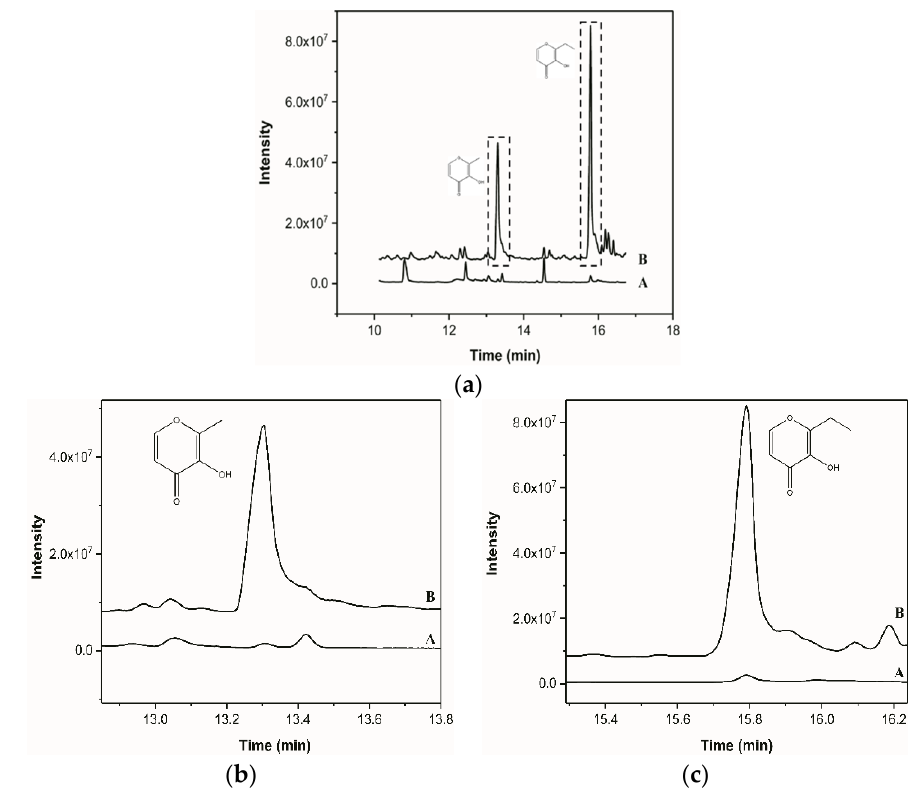
Figure 2. Chromatograms of maltol and ethyl maltol pretreated by dispersive liquid-liquid microextraction combined with headspace solid phase microextraction (A, without DLLME treatment and B, with DLLME treatment): ( a ) Chromatograms of maltol and ethyl maltol standard; ( b ) enlargement of the chromatogram of maltol standard; ( c ) enlargement of the chromatogram of ethyl maltol standard.